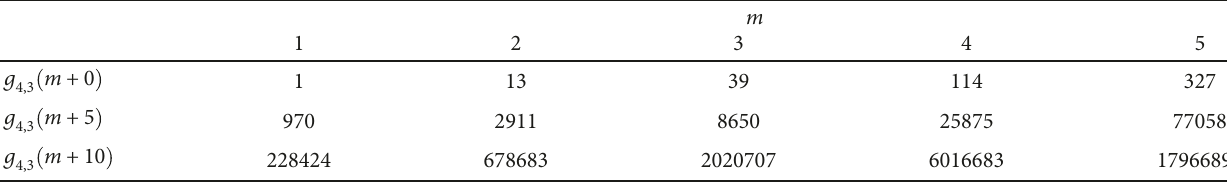
n sequence for n ≤ 15 . 4,3